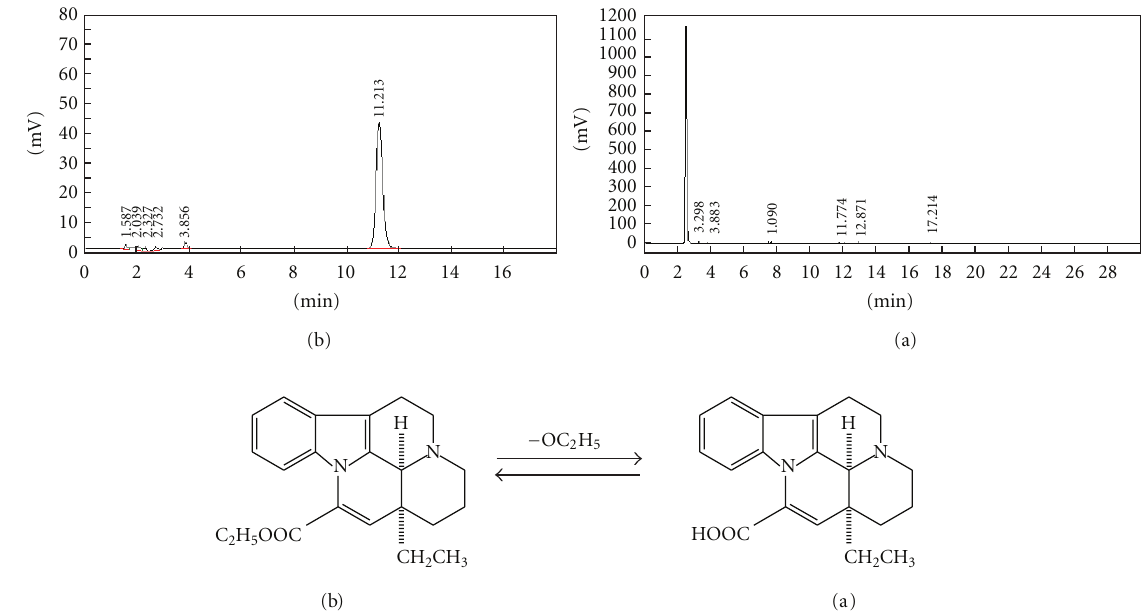
Figure 7: Chromatograph of de-acetyl-vinpocetine (a) and vinpocetine (b).